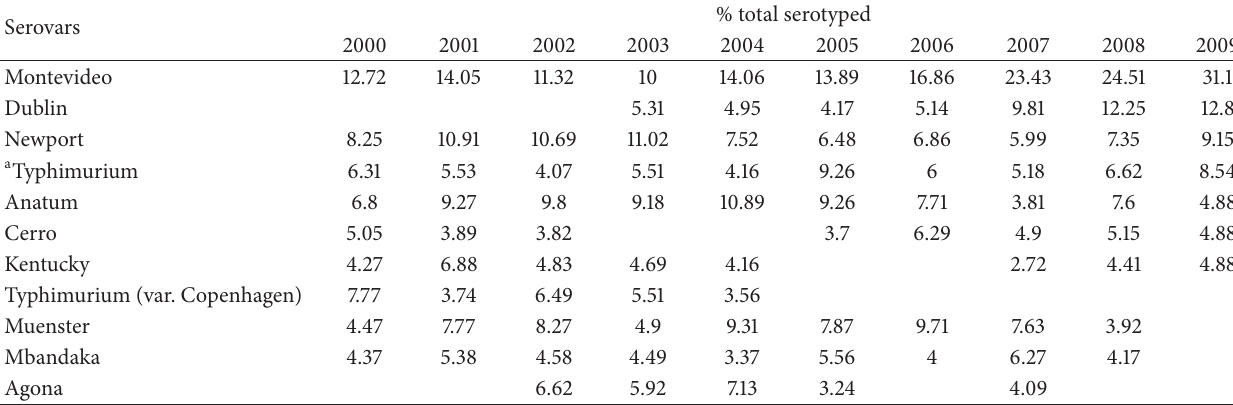
Table 12: Examples of Salmonella serovars profiles from ground beef collected in the US [36].